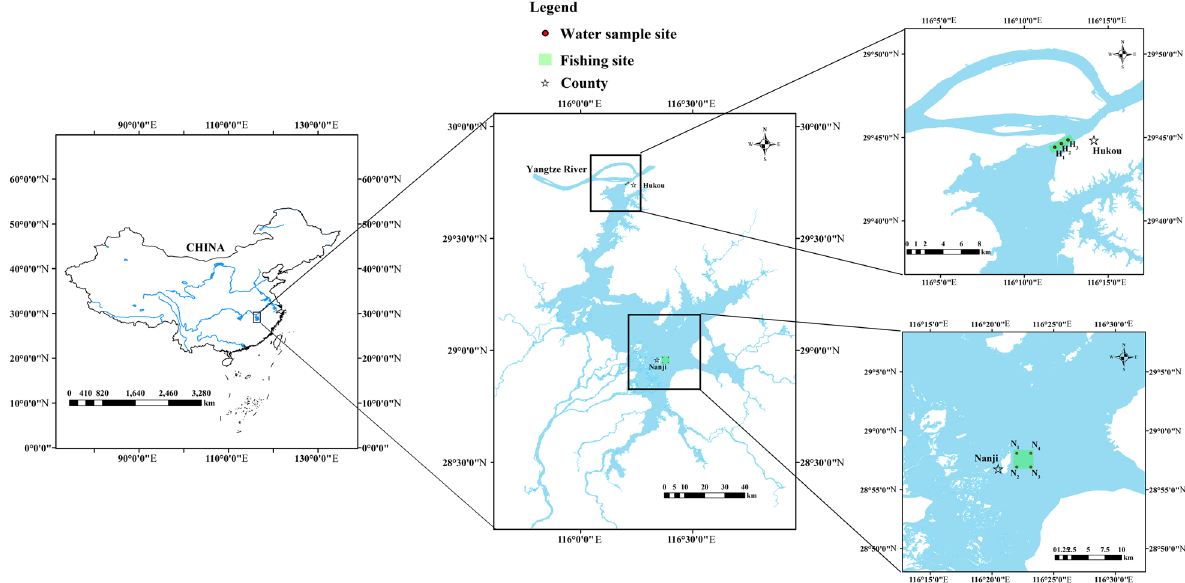
Fig. 1 Map of the study area and location of the sampling